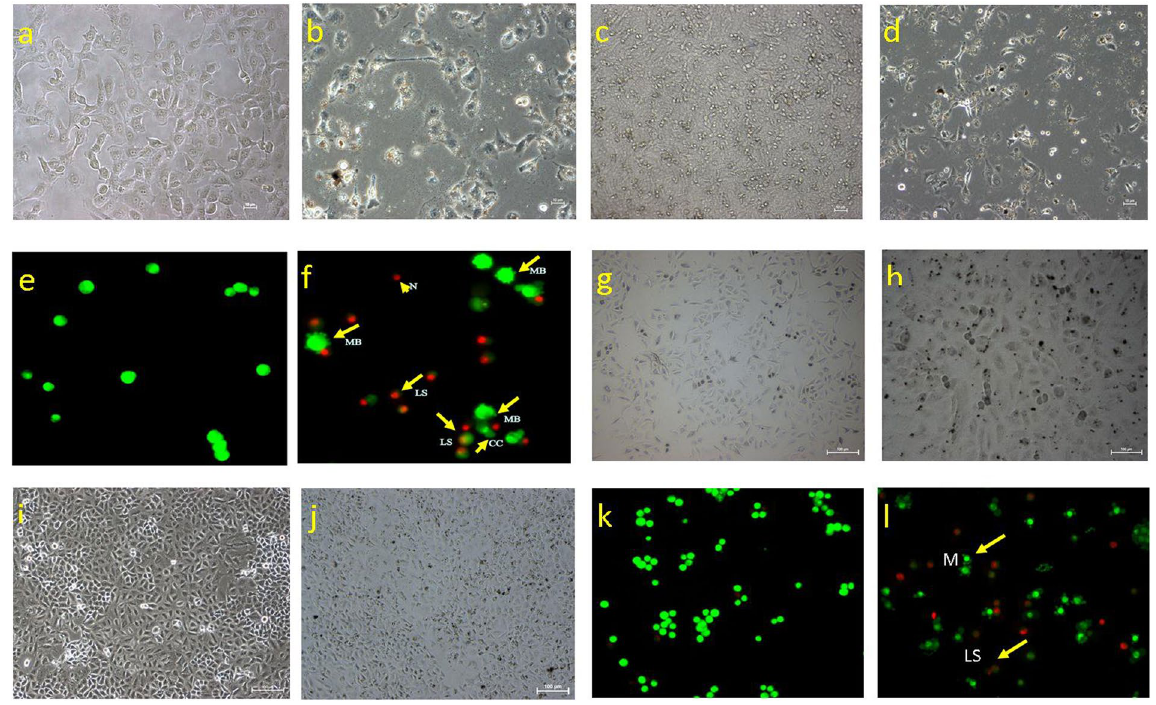
Figure 6. Microscopy of HT29 ( a,b,c,d,e,f ) and A549 ( g,h,i,j,k,l ) cells treated with CPT-CEF to show changes in cell morphology. Cells were exposed to the IC 50 concentration of CPT-CEF and viewed at 24 and 48 h. Panel a and g (Untreated cells at 24 h), b and h (IC 50 treated cells for 24 h), c and i (Untreated cells at 48 h), and d and j (IC 50 treated cells for 48 h). Under phase contrast microscopy, cell morphology changes in treated cells are clearly visible in comparison to untreated cells; the cell membrane is evidently damaged. Panels’ e and f show fluorescent micrographs of AO/PI double-stained human colorectal cancer cells (HT29). Cells were exposed to the IC 50 concentration of CPT-CEF (panel f and i) or vehicle (panel e and k) for 48 h. Cell apoptosis was assayed by AO/PI staining to detect chromosomal condensation (CC), late stage apoptosis (LS), necrosis (N), and membrane blebbing (MB), as shown in the micrograph. Microscope magnification × 100 and scale bar of 10 µ m (HT29) and scale bar of 100 µ m (A549) were applied for the